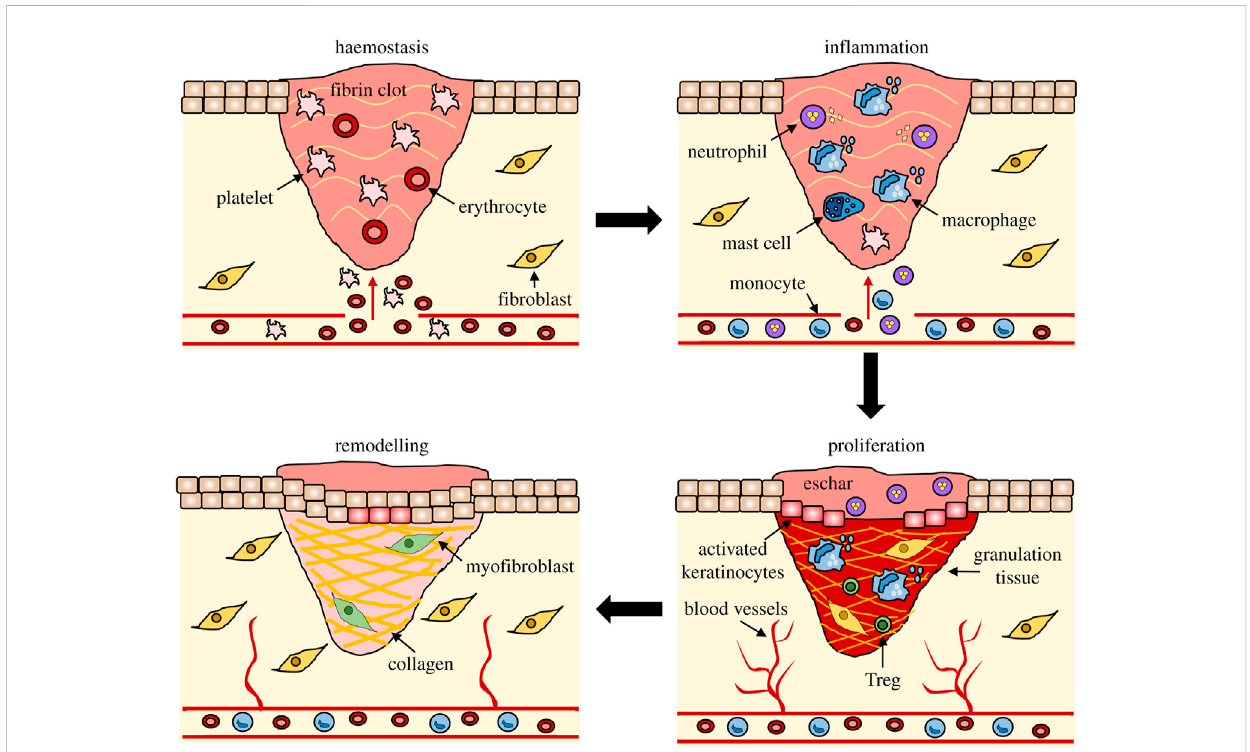
The stages of wound repair and their major cellular components (Wilkinson and Hardman,